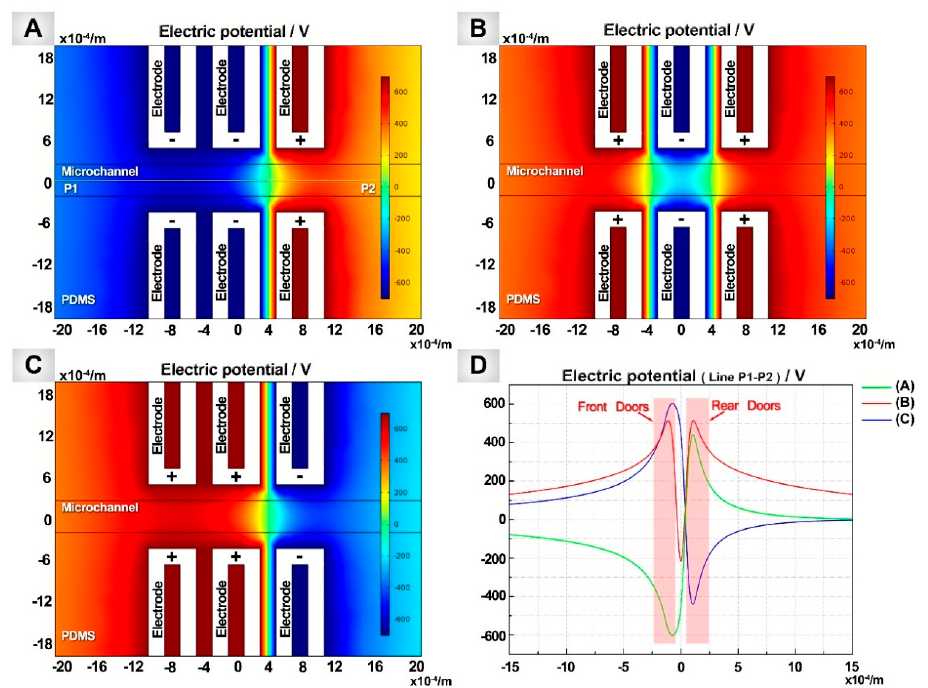
Figure 4. Numerical simulation of the electric potential applied to the electrodes. The value of the electric potential applied on the positive electrodes was 700 V, negative electrodes − 700 V. ( D ) The value of the electric potential applied on the central datum line (shown as line P1–P2 in A) of the ( A – C ) under the different distributions of electric field.